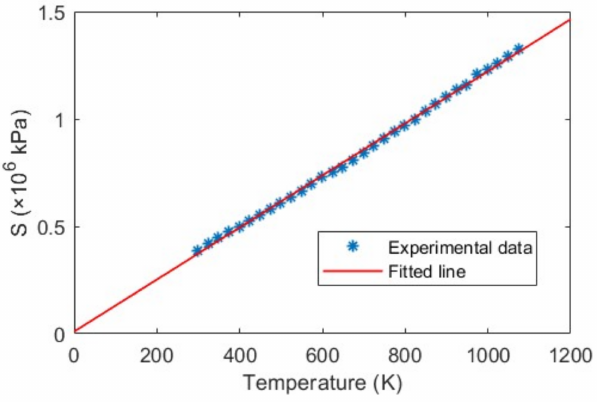
Figure 9. Linear relationship between temperature T and S